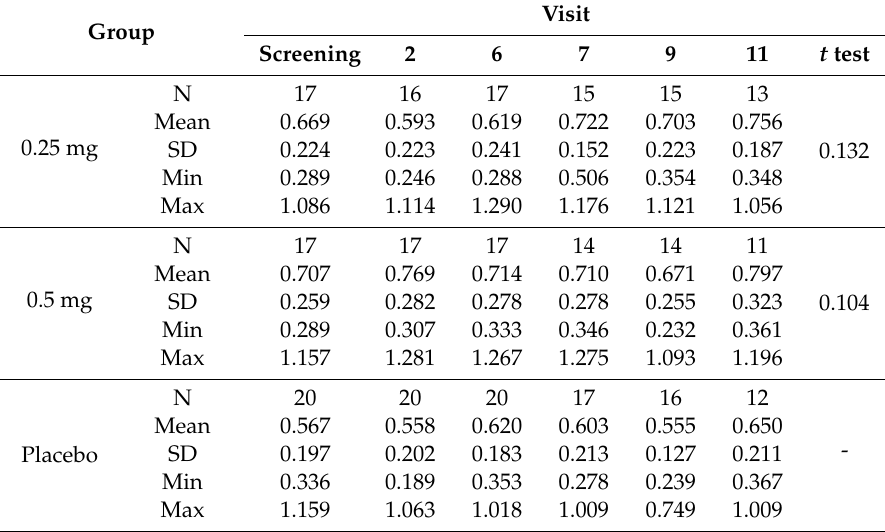
Table 4. Data on CD4 T cells number in trial participants at di ff erent visits (cells × 10 9 / L).